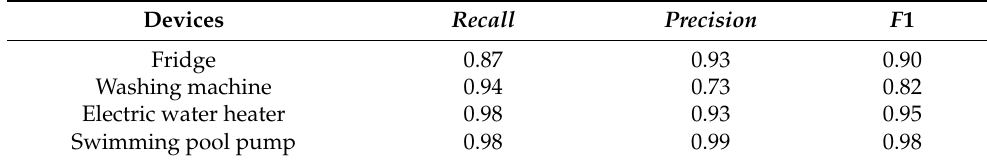
Table 11. Decision tree results.